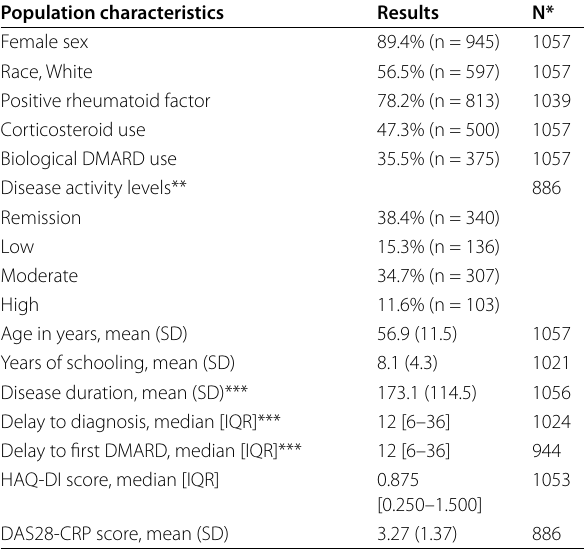
Table 1 General characteristics of the studied population of RA patients Population characteristics